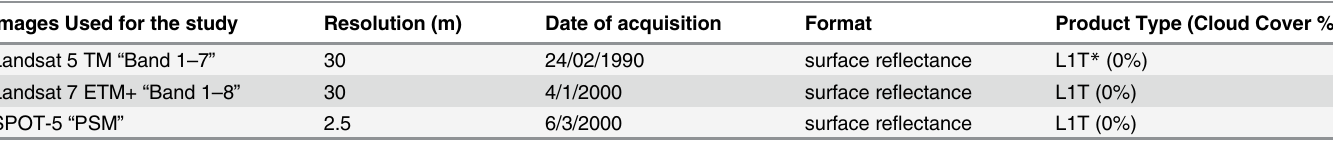
* Level 1T (L1T) (precision and terrain corrected data) provides systematic radiometric accuracy, geometric accuracy by incorporating ground control points, while also employing a Digital Elevation Model (DEM) for topographic accuracy